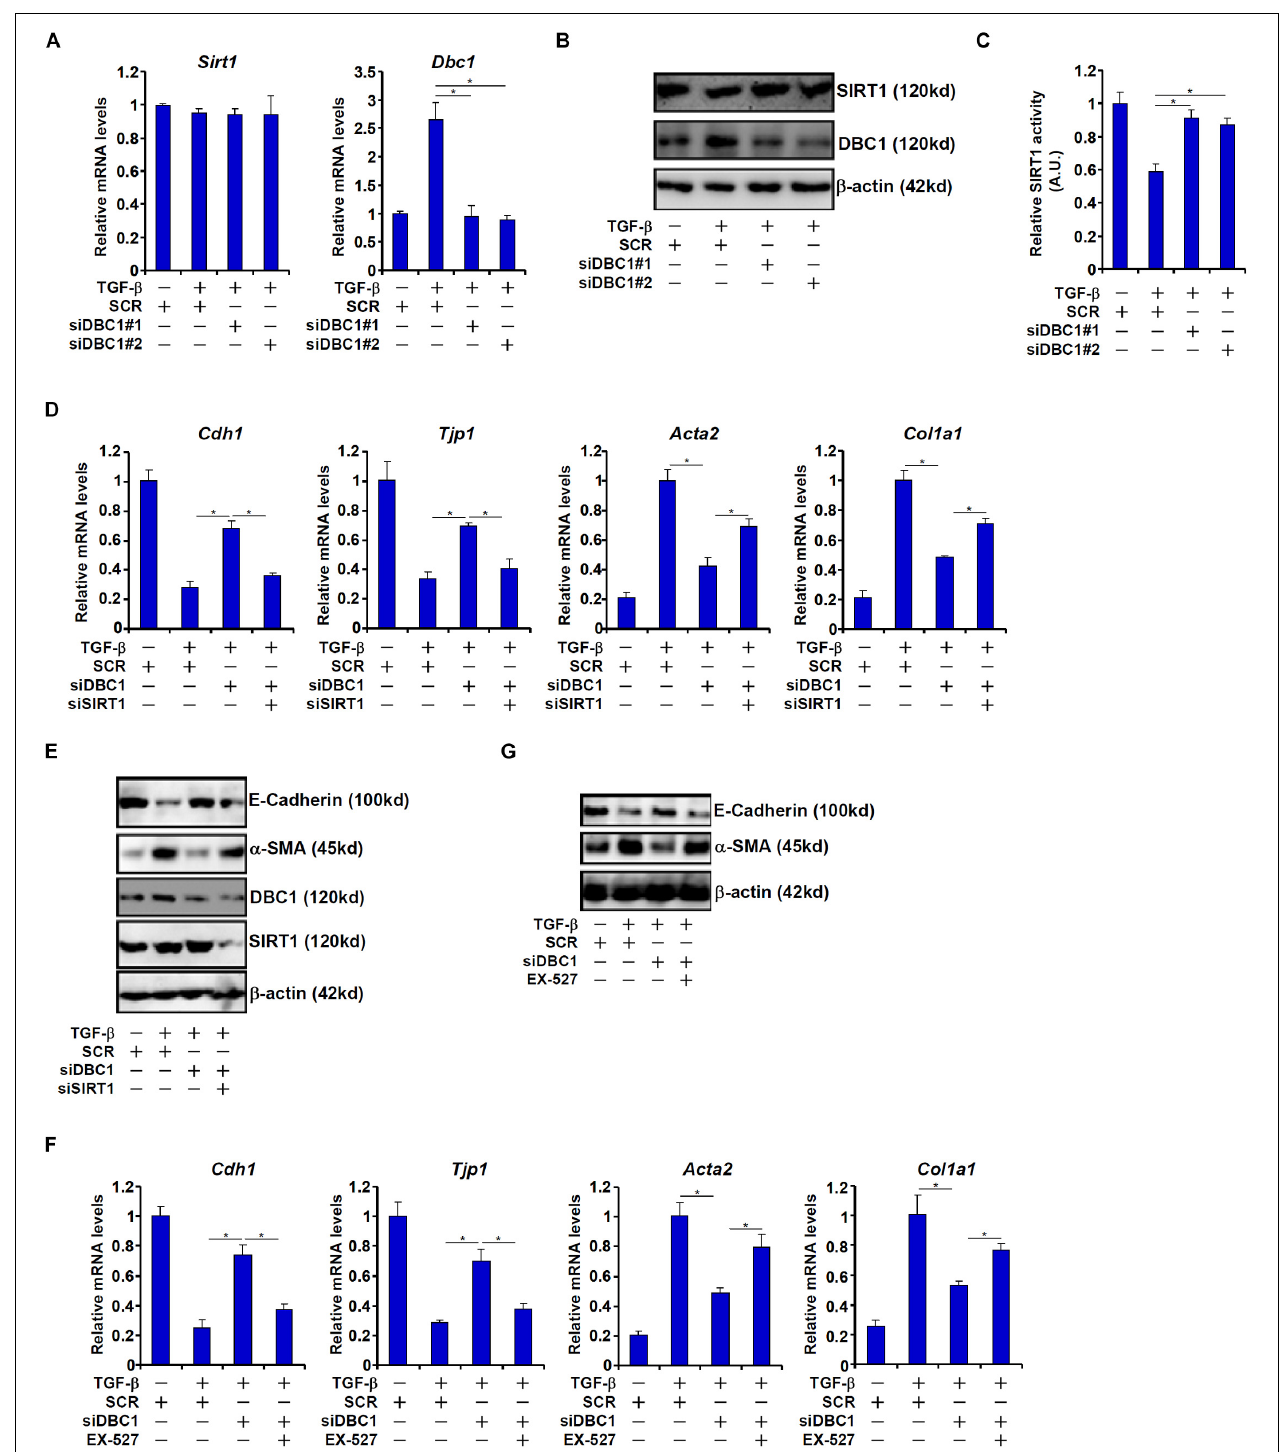
FIGURE 3 | DBC1 contributes to TGF- β induced EMT by repressing SIRT1 activity. (A–C) IEC-6 cells were transfected with siRNAs targeting DBC1 or scrambled siRNAs followed by treatment with TGF- β (2 ng/ml). Expression levels of SIRT1 and DBC1 were examined by qPCR and Western. SIRT1 activity was determined by a colorimetric kit. (D,E) IEC-6 cells were transfected with indicated siRNAs followed by treatment with TGF- β (2 ng/ml) for 48 h. Gene expression levels were examined by qPCR and Western. (F,G) IEC-6 cells were transfected with indicated siRNAs followed by treatment with TGF- β (2 ng/ml) in the presence or absence of EX527 (10 mM) for 48 h. Gene expression levels were examined by qPCR and Western. All experiments were performed in triplicate wells and repeated three times. One representative experiment is shown.